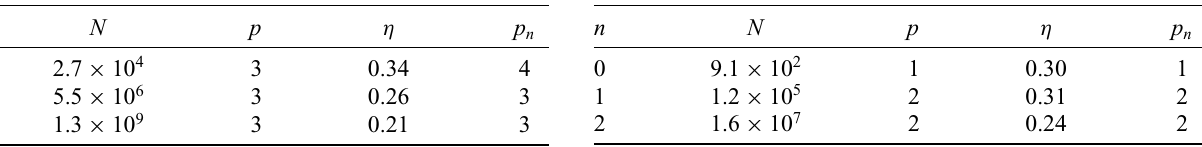
TABLE I. Optimized parameters for target Fock states 0, 1, and 2, for precision (cid:9) = 0.1 with 95% confidence.